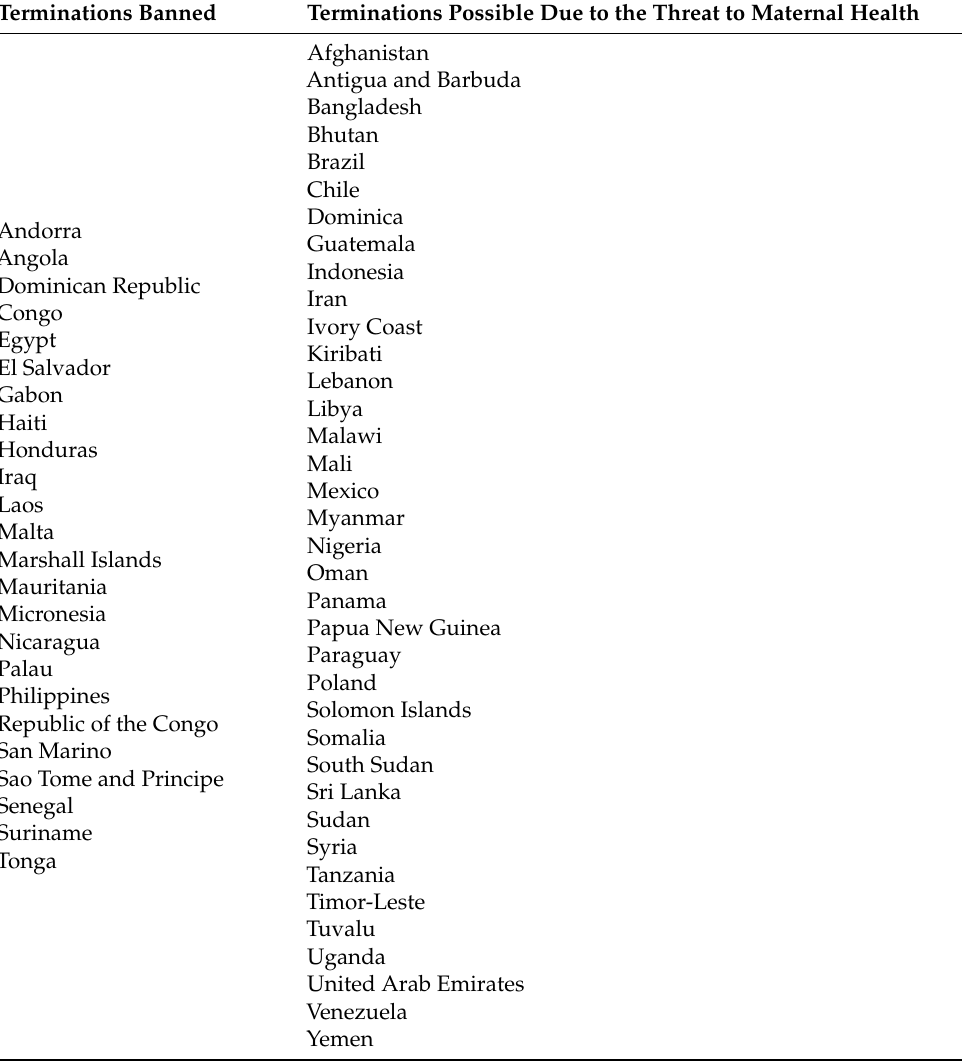
Table 1. Countries with restrictive abortion laws with regard to indications for